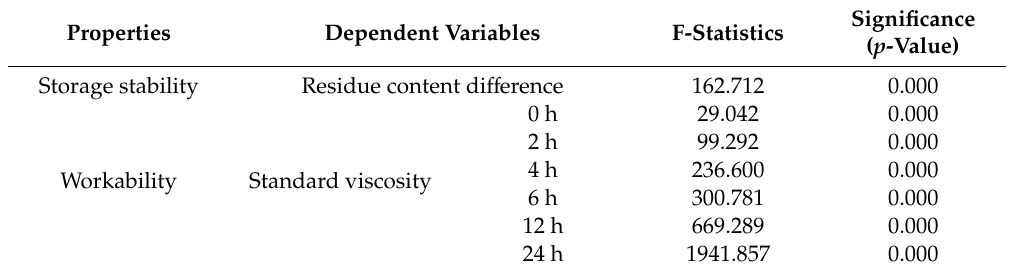
Table 3. Analysis of variance (ANOVA) results for the residue content di ff erence and standard